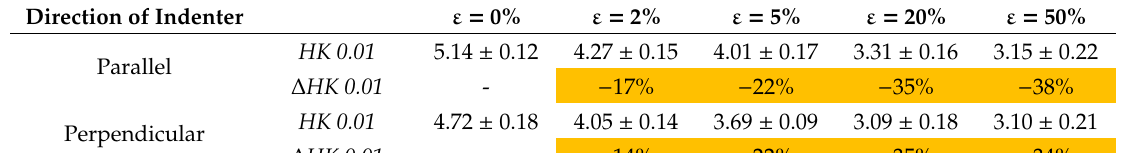
Table 4. Results of microhardness tests for polymers deformed by tension.